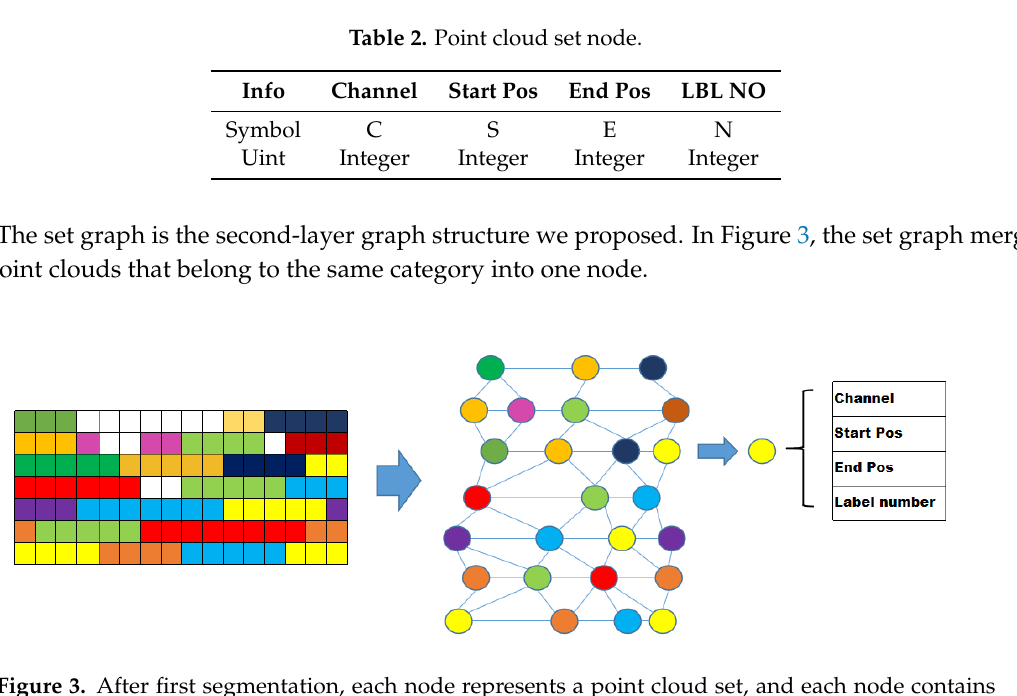
Figure 3. After first segmentation, each node represents a point cloud set, and each node contains information such as channel number, starting position, ending position and category number. Lines connecting nodes represent the neighbor relationship of the point cloud